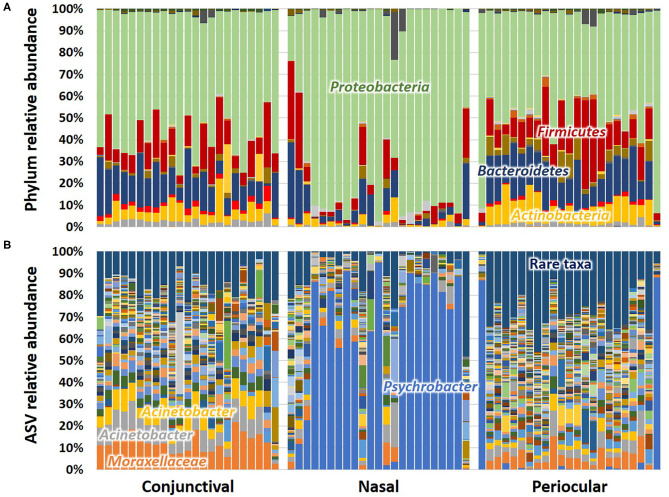
Stacked bar charts showing the taxonomic composition of all 23 samples at each site, annotated to the level of phylum (A) and amplicon sequence variant (ASV) (B). Dominant taxa are labeled directly on the chart.